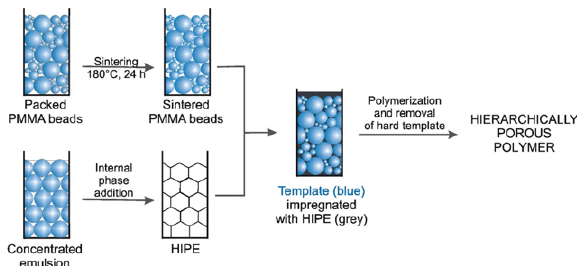
Figure 6 : Combination of hard sphere and emulsion templating